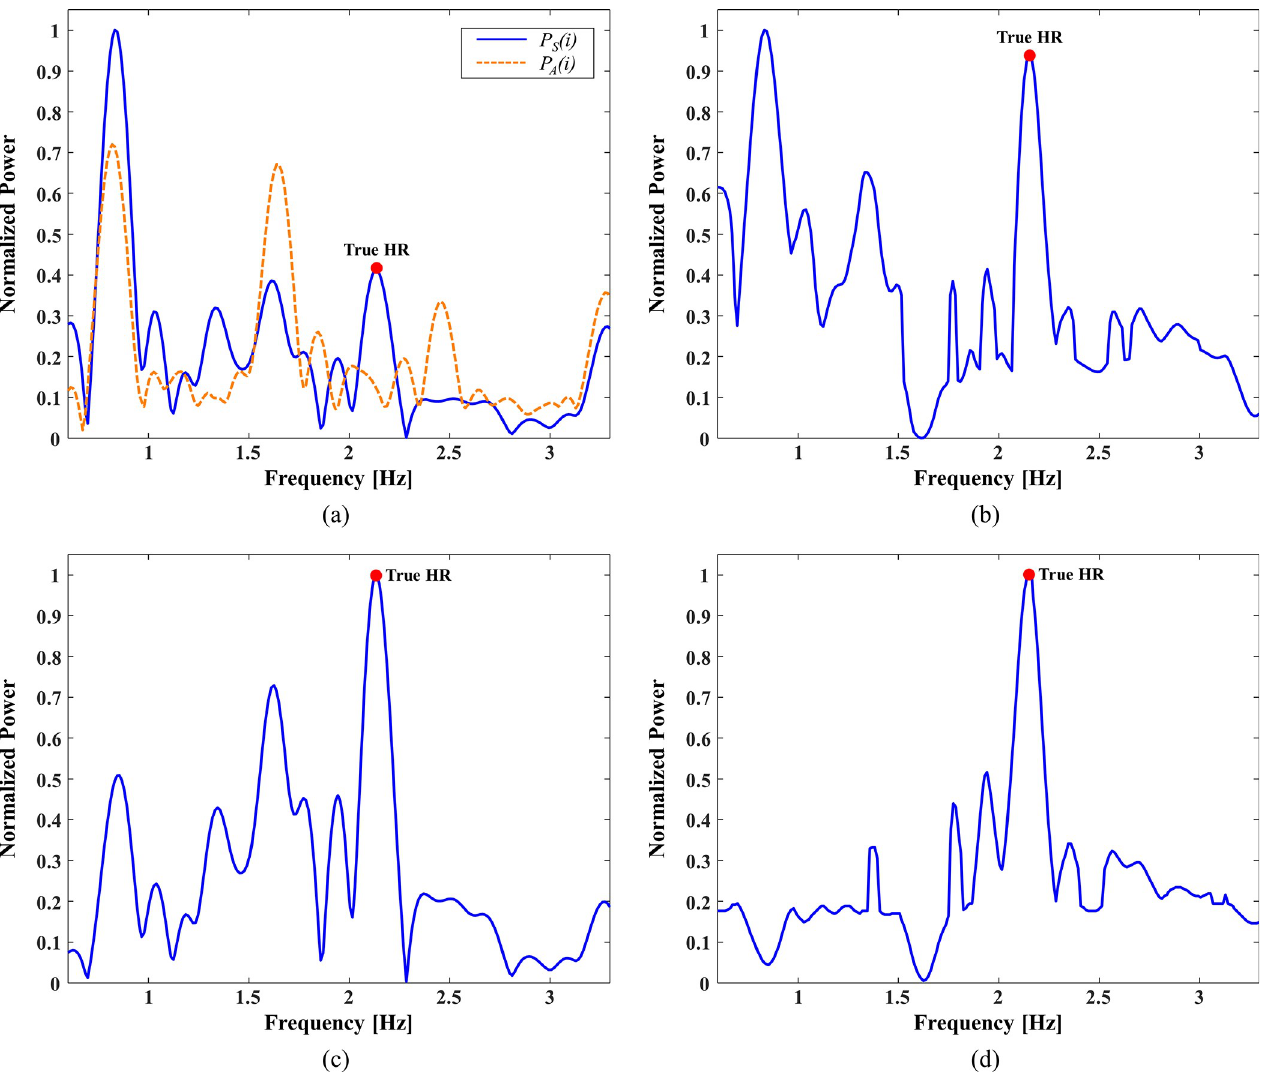
Fig 4. Sample HR estimation results obtained with MA cancellation. (a) power spectrum P line), (b) power spectrum P cancellation based on ^ P